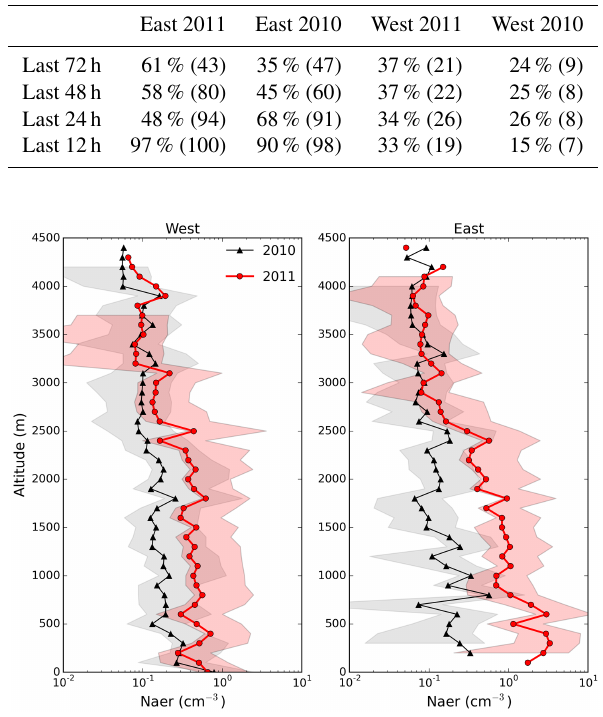
Figure 13. Averaged vertical profiles of number concentration of aerosols (cm − 3 ) on both sides of the peninsula over all the flights (as for Fig. 11). Shaded areas indicate the spread of the data between absolute minimum and maximum values at each level. West refers to 74–67 ◦ W, and east refers to 65–60 ◦